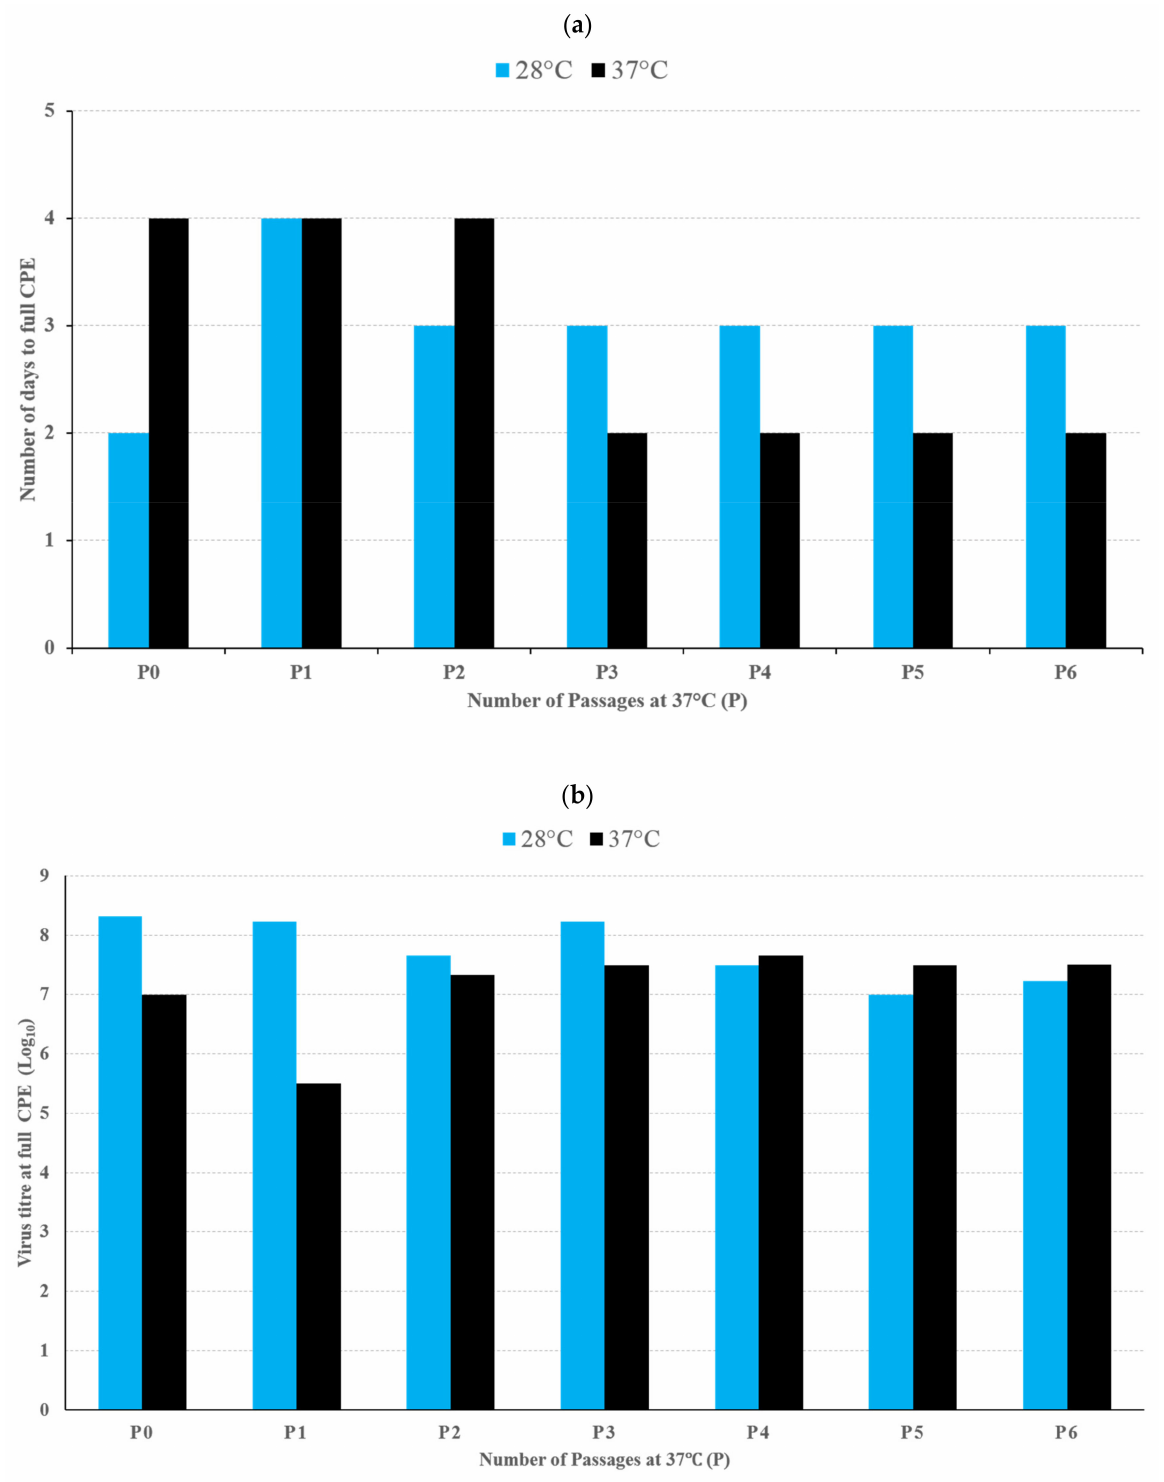
Figure 2. Assessment of temperature reversion growth characteristics of EV71:TLL β P20 following 6 successive passages in Vero cells incubated at 37 ◦ C. Growth characteristics of the virus derived from each successive culture at 37 ◦ C in terms of ( a ) virus growth kinetics by cell death and ( b ) virus titre in CCID 50 /mL at full cytopathic effect (CPE) at incubation temperature of 28 ◦ C (blue bar) and 37 ◦ C (black